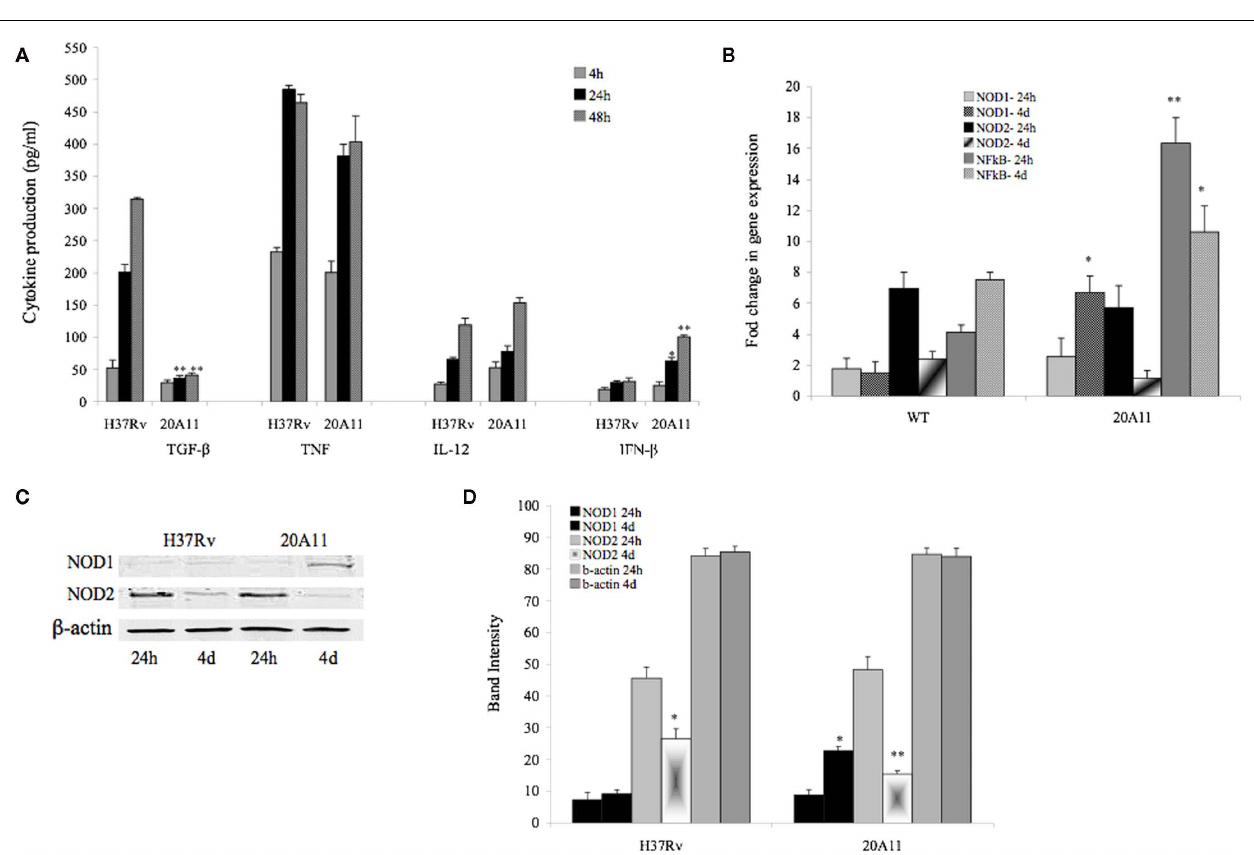
FIGURE 3 | (A) Production of IL-12,TNF, IFN- β , andTGF- β cytokines over time by macrophages infected with M. tuberculosis H37Rv and 20A11 mutant. Cells were infected with MOI of 10.The numbers represent the mean ± SD of three independent experiments.The significance of differences between the 20A11 mutant and the wild-type strain was evaluated * p < 0.05 and ** p < 0.01 at the same time point infections. (B) Expression profile of intracellular pattern recognition receptor NOD1 and NOD2 and NF- κ B in H37Rv- or 20A11-infected macrophages analyzed by Real-Time quantitative PCR. Bars represent the fold change between differentially expressed transcripts from wild-type and mutant infected cells. Positive values indicate relative increased expression levels over uninfected control.The numbers represent the mean ± SD of three independent experiments.The differences